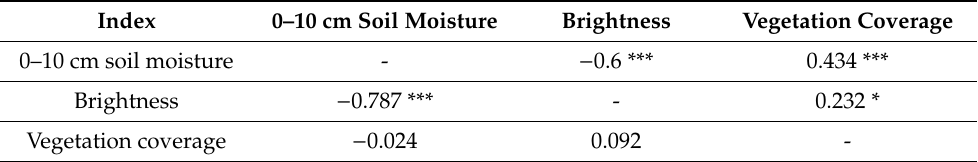
Table 2. Correlation analysis of factors a ff ecting the soil moisture